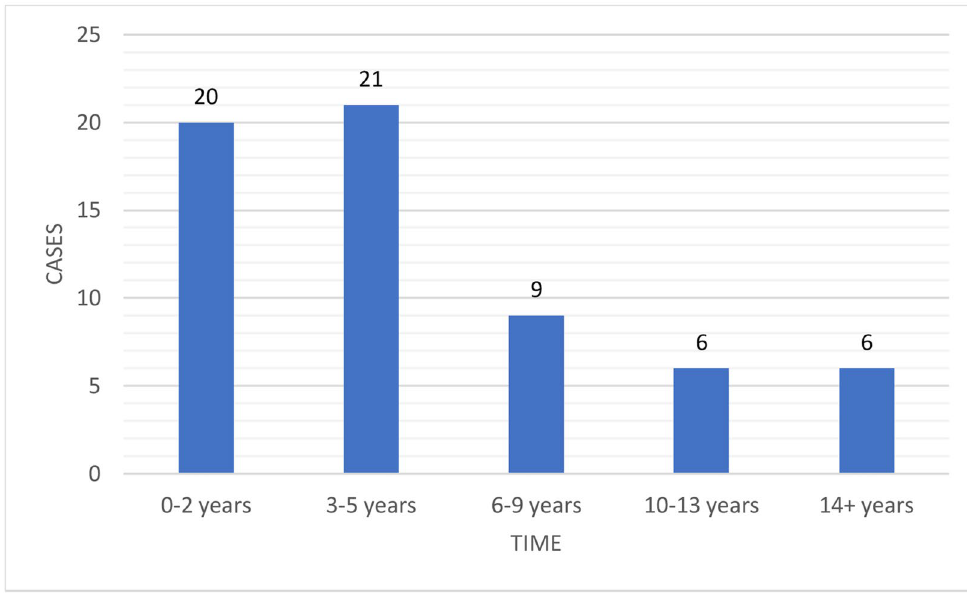
Figure 2. Malignant transformation time from oral epithelial dysplasia to oral squamous cell carcinoma.